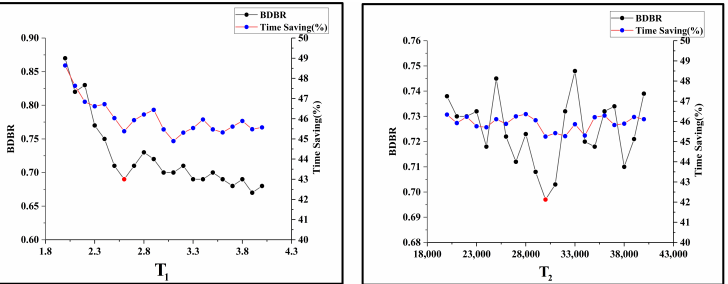
Figure 7. Training results of two thresholds concerning both BDBR and time